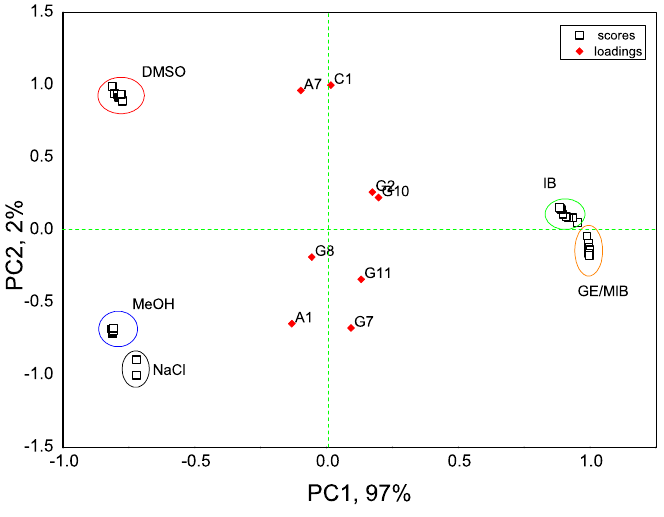
Figure 5. PCA bi-plot of E-tongue response in IB, DMSO, GE / MIB, and MeOH aqueous solutions after data normalization and solvent influence minimization.